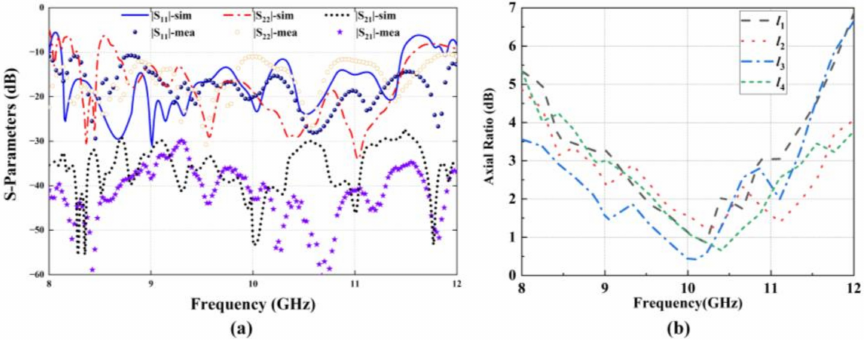
Figure 10. ( a ) Simulated and measured S-parameters and ( b ) simulated AR of the microstrip quad- vortex-beam planar array.